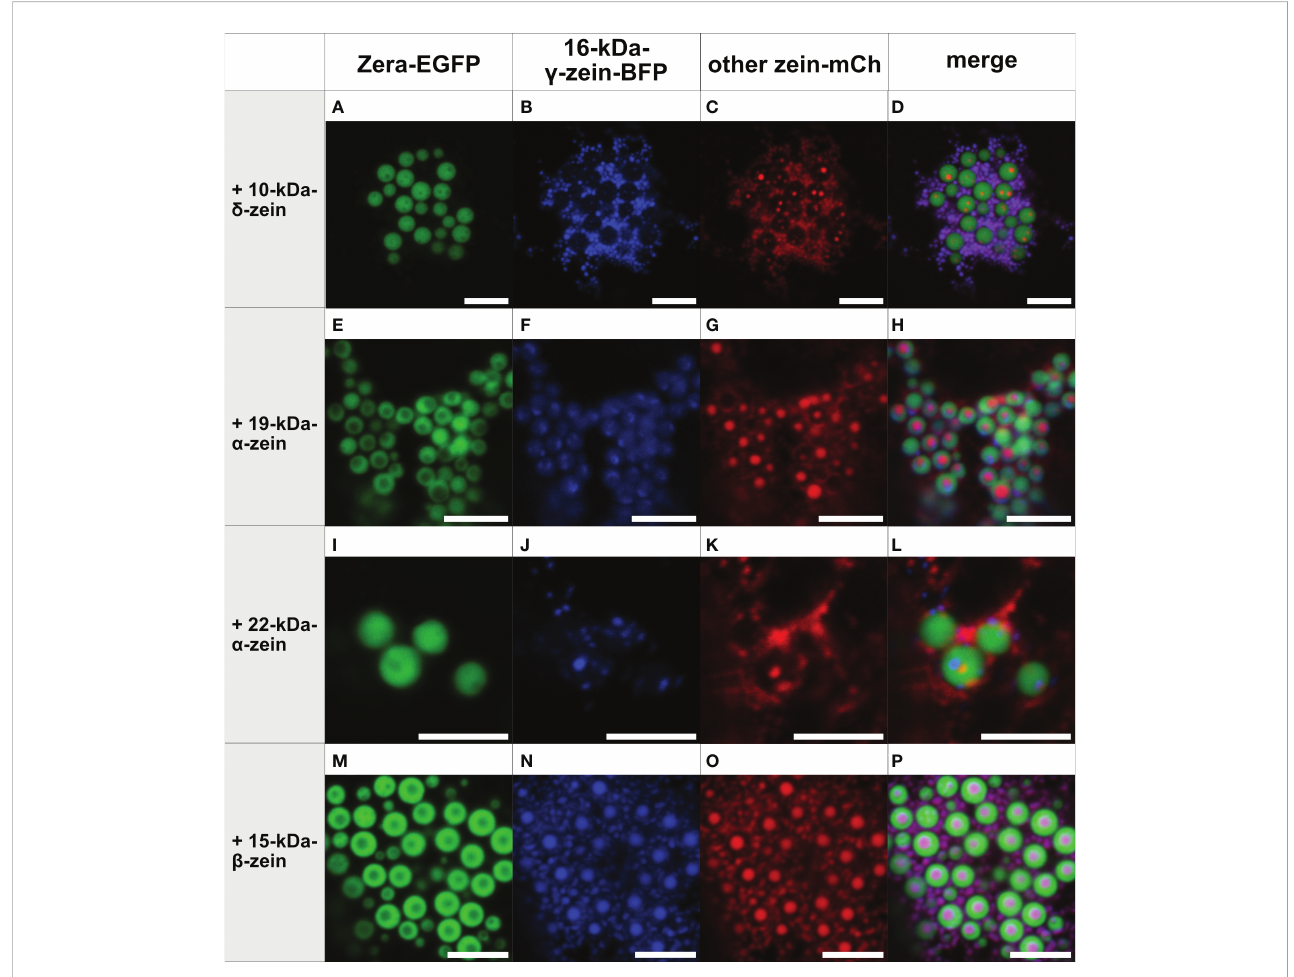
FIGURE 3 Co-expression of Zera-EGFP and 16-kDa- g -zein-BFP together with a third zein component fused to mCherry (representative images recorded with confocal laser scanning microscopy). First panel: Zera-EGFP; second panel: 16-kDa- g -zein-BFP; third panel: mCherry-fusion of the zeins listed on the left; fourth panel: overlay images. (A-D) Zera-EGFP + 16-kDa- g -zein -BFP +10-kDa- d -zein-mCherry, (E-H) Zera-EGFP + 16-kDa- g -zein -BFP + 19-kDa- a -zein-mCherry, (I-L) Zera-EGFP + 16-kDa- g -zein -BFP + 22-kDa- a -zein -mCherry, (M-P) Zera-EGFP + 16-kDa- g -zein -BFP + 15-kDa- b -zein-mCherry. Scale bar 5